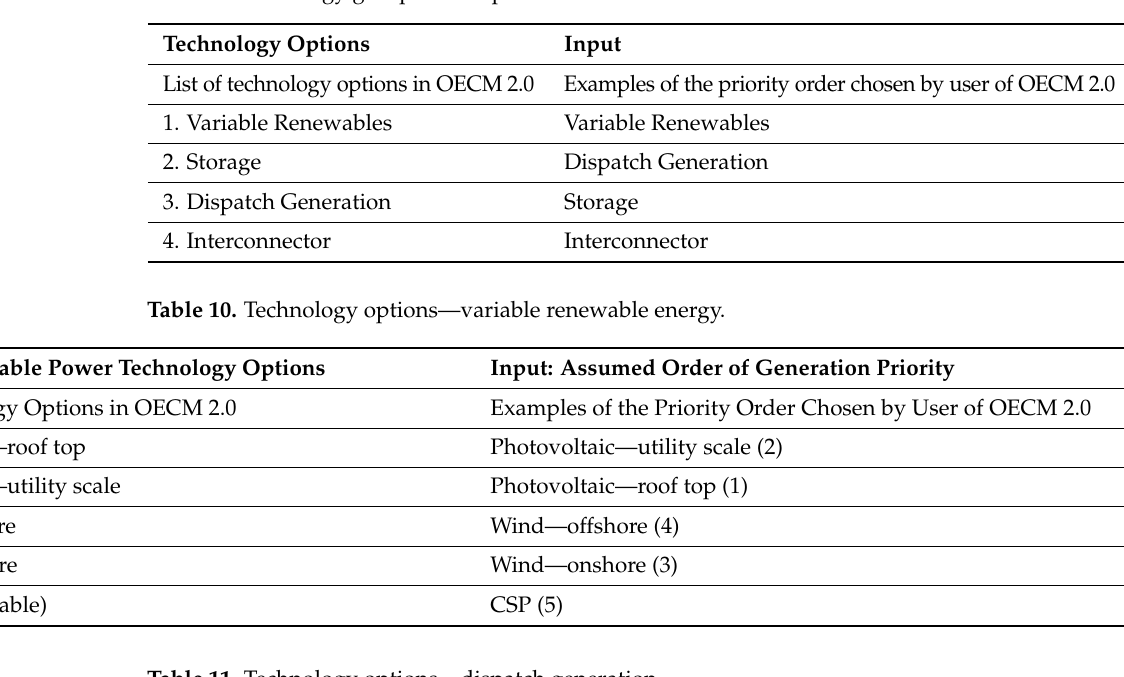
Table 11. Technology options—dispatch